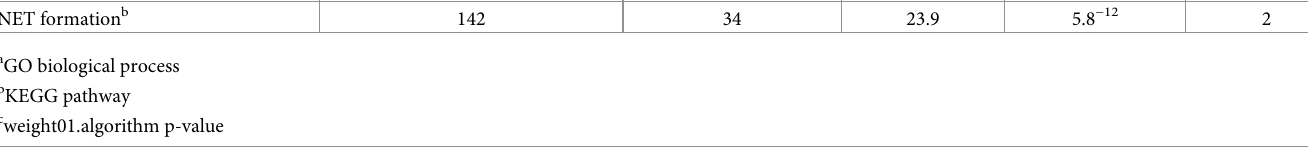
Table 3. Pathways significantly enriched with upregulated genes when comparing TB patients with high PET-scores to TB patients with low PET-scores. Pathway Total annotated genes Number Up % Up P-value Rank Neutrophil degranulation a 464 Platelet degranulation